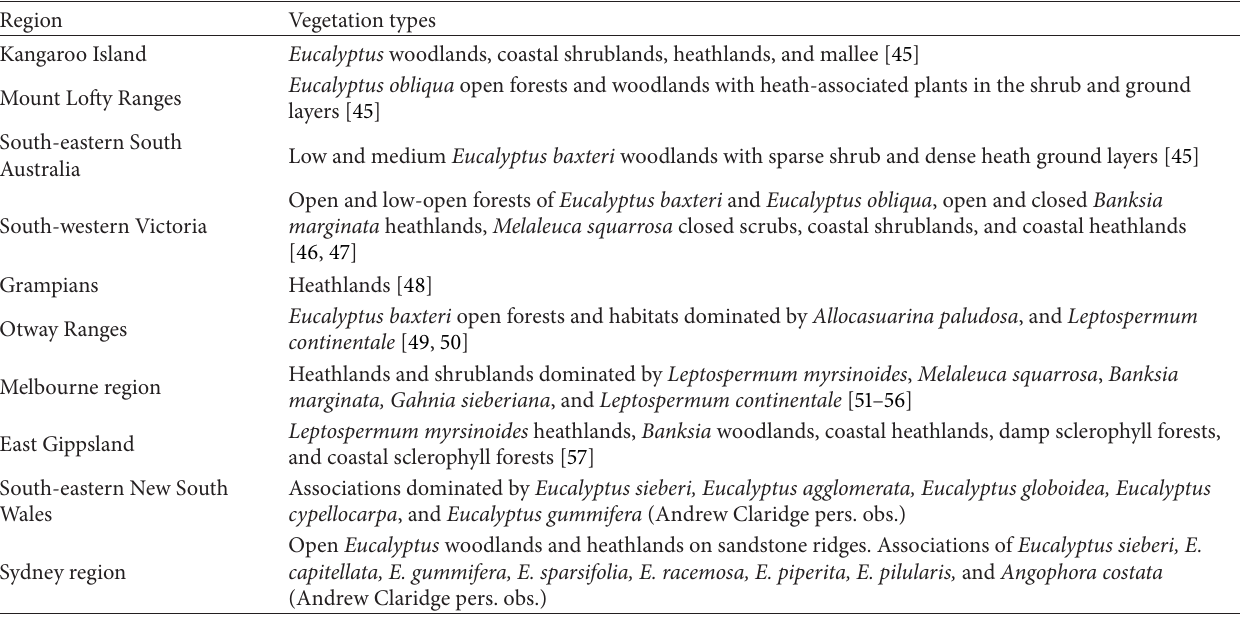
Table 1: Vegetation types used by Isoodon obesulus obesulus throughout its